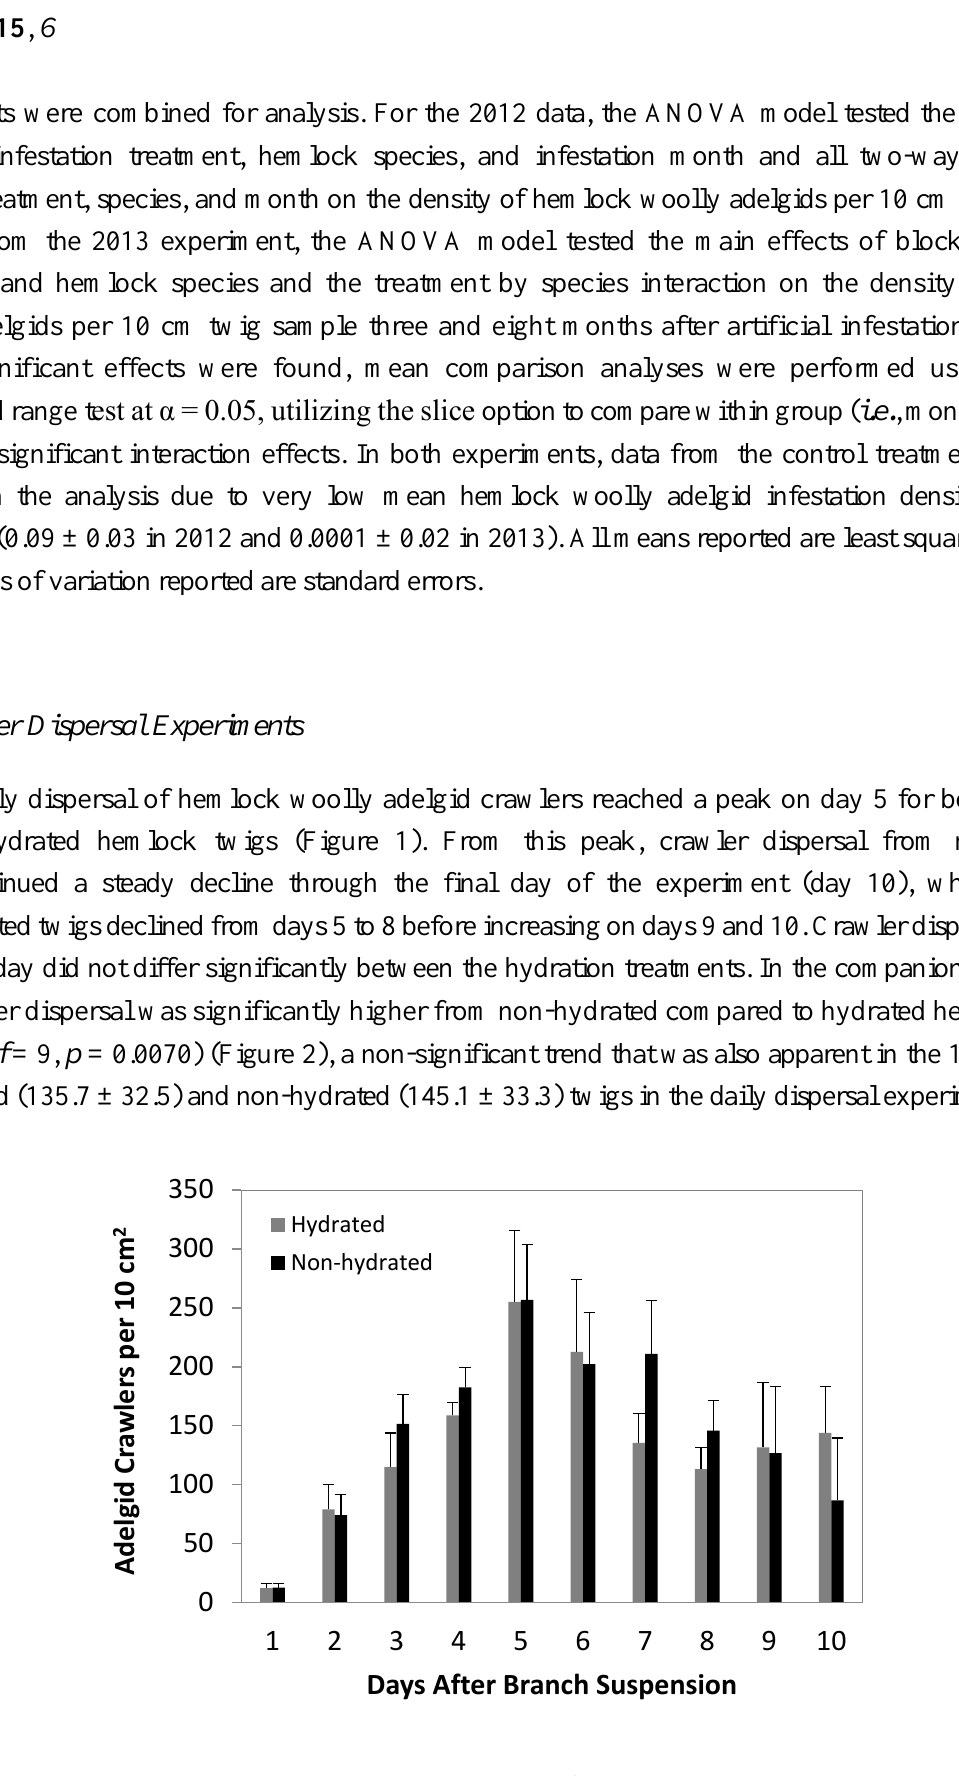
Figure 1. Daily dispersal, over a 10-day period, of hemlock woolly adelgid progrediens crawlers from hydrated and non-hydrated 10 cm long sistens infested eastern hemlock